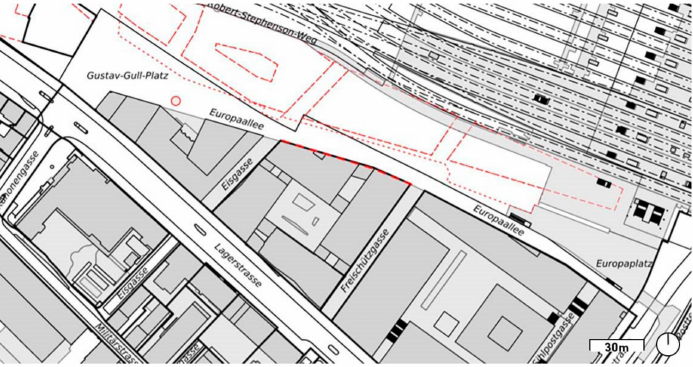
Figure 3. Cadastral map Europaallee Zurich, Switzerland